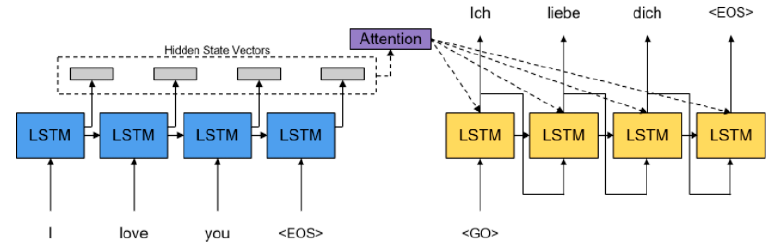
Figure 2. The attention mechanism applied to an encoder–decoder model.